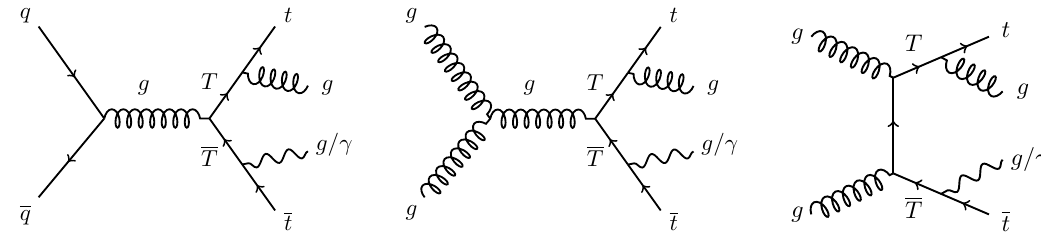
Figure 1 . Feynman diagrams for pair production of top partners at the LHC and their decays into TT ! tt + g + g=(cid:13) (cid:12)nal states.